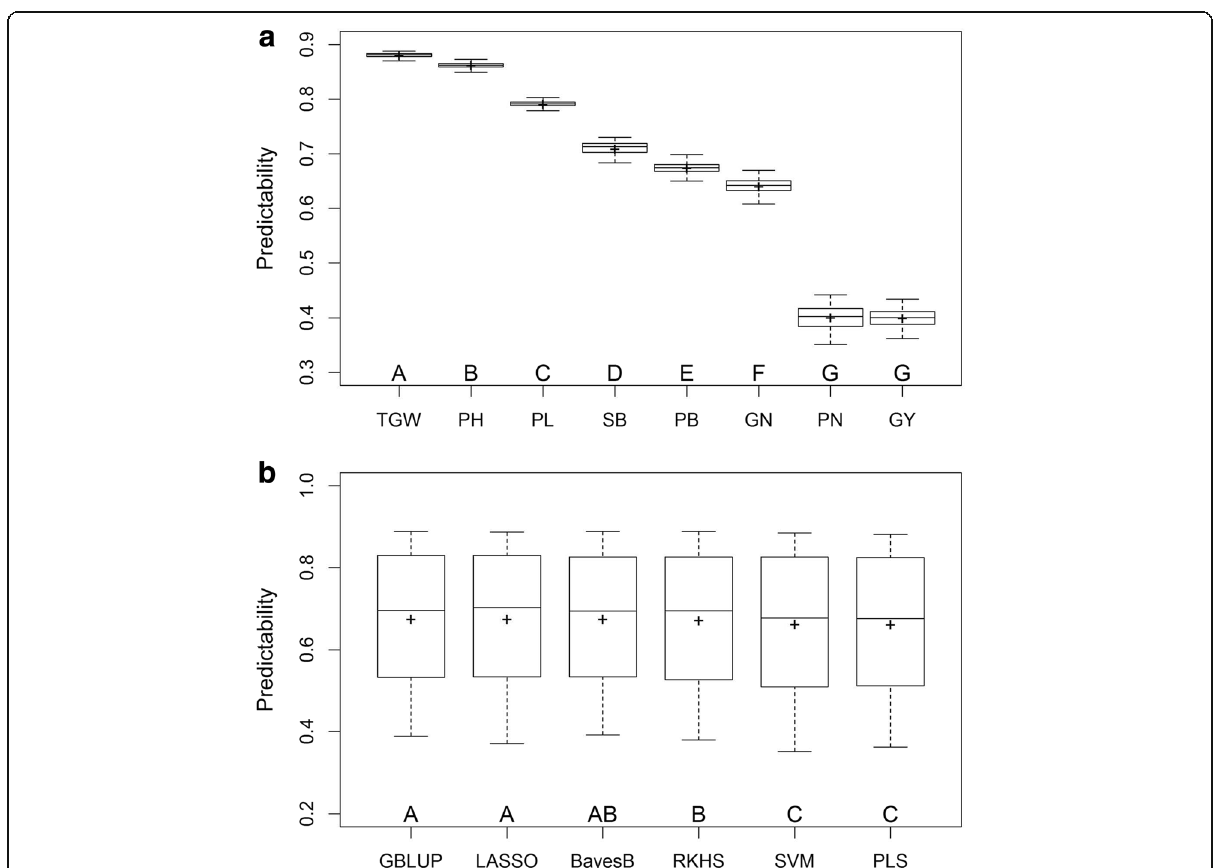
Fig. 2 Multiple comparisons illustrated by boxplots. In each panel, different capital letters above the group labels indicate significant differences between groups. In each boxplot, the cross sign represents the mean predictability. Panel a compares the predictabilities for the eight traits over six methods and 20 replications. Panel b compares the predictabilities of the six methods across eight traits and 20